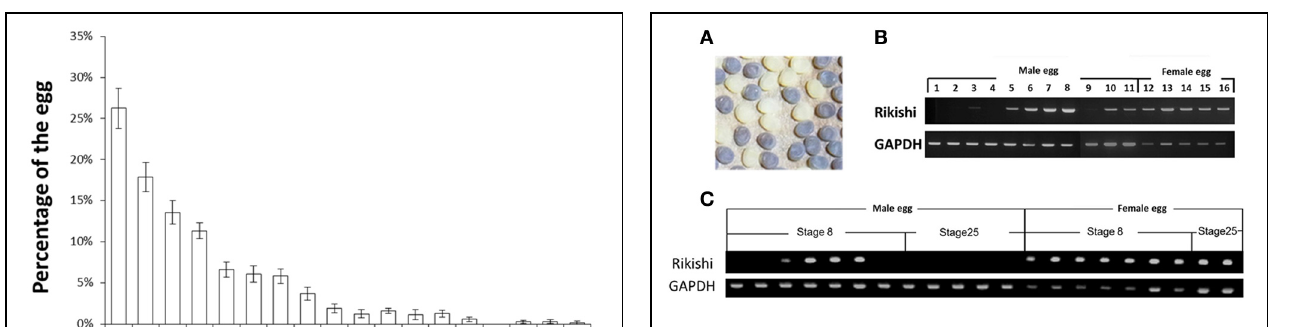
FIGURE 6 | Detection of polar body-nucleus-derived cells by PCR. (A) In the sex-limited black egg strain 2-pB, female eggs are black ( + pe / pe ) while male eggs are white ( pe / pe ). (B) Genomic DNA extracted from each egg at stage 8 was analyzed by PCR using the W-chromosome-specific DNA marker. (C) The same PCR analysis as in (B) was performed using genomic DNA extracted from each egg at stage 25 (a taenidium in spiral bands formed in the tracheal tube at this stage) as well as stage